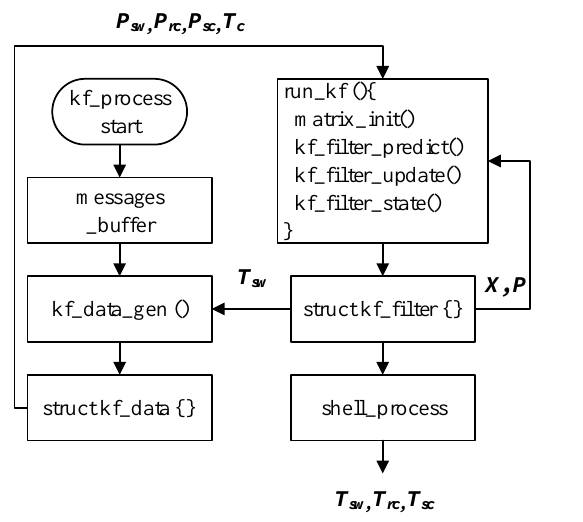
Figure 13. The workflow of the KF algorithm process. Table 1. The data range and the resolution of the